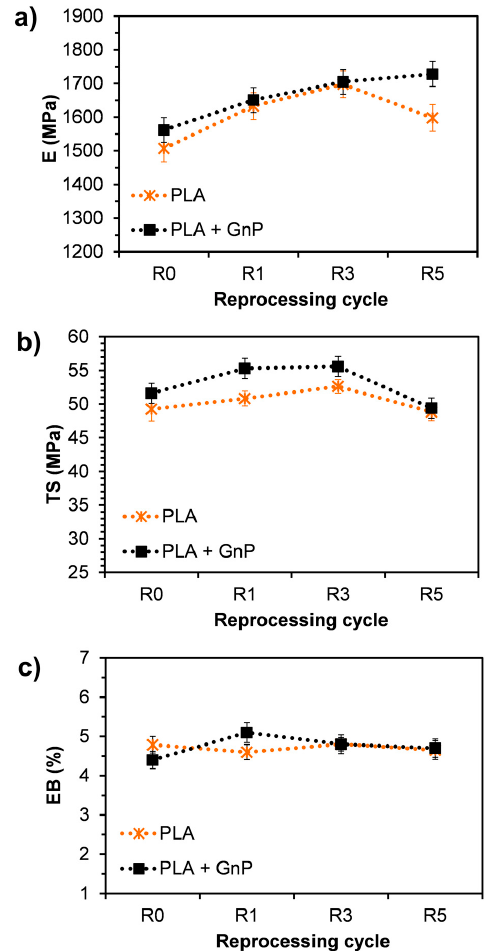
Figure 10. Mechanical properties of neat PLA and PLA + GnP as a function of reprocessing cycles: ( a ) Elastic modulus (E); ( b ) tensile strength (TS) and ( c ) elongation at break (EB).